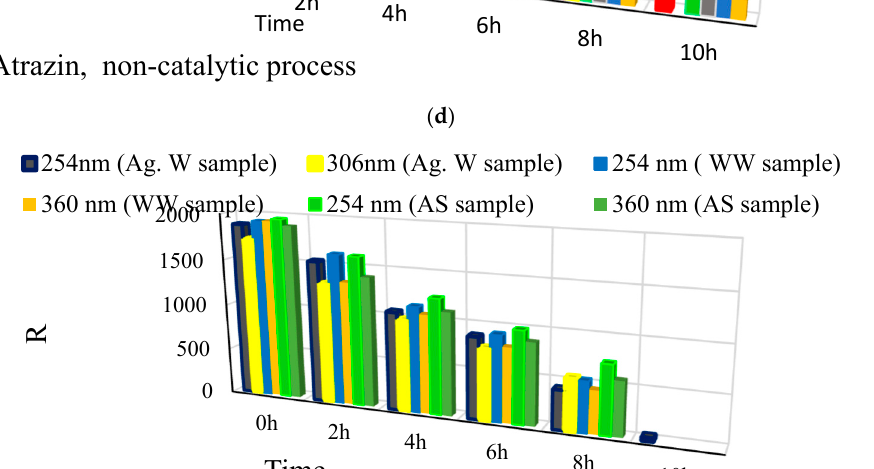
Figure 6. Comparison of photodegradation, with and without catalyst, of pesticides in different water media: concentration of pesticides (R(ppb)) as a function exposure time of irradiation at both wavelengths of UV; ( a ). Dimethoate (noncatalytic process), ( b ). Dimethoate (Catalytic process), and ( c ). Atrazin (noncatalytic process). (d). Atrazin (Catalytic process)